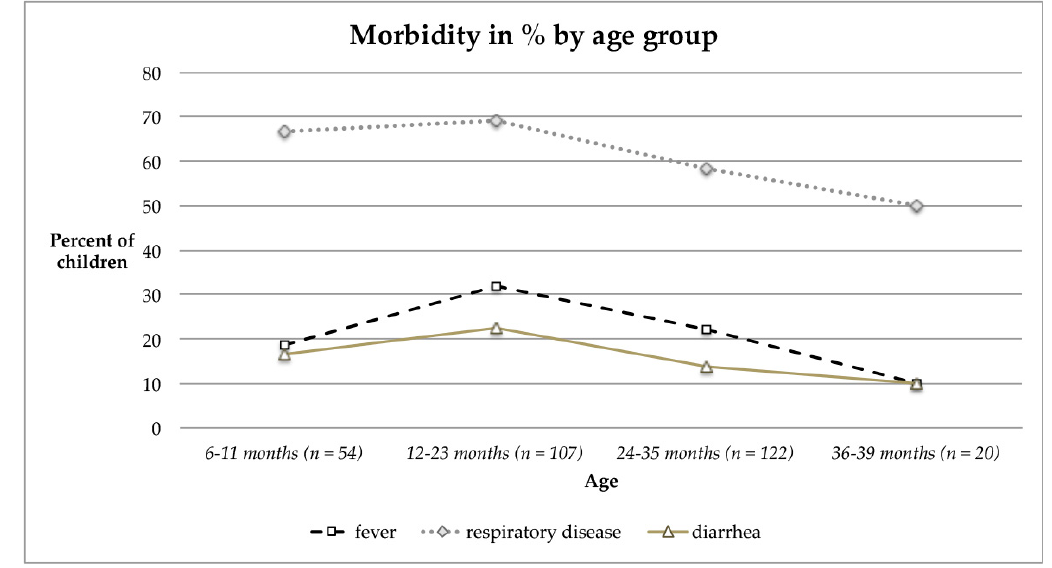
Figure 1. Proportion (%) of children ( n = 303) by age suffering from fever, respiratory disease or diarrhea during the last week prior/or during medical checkup.